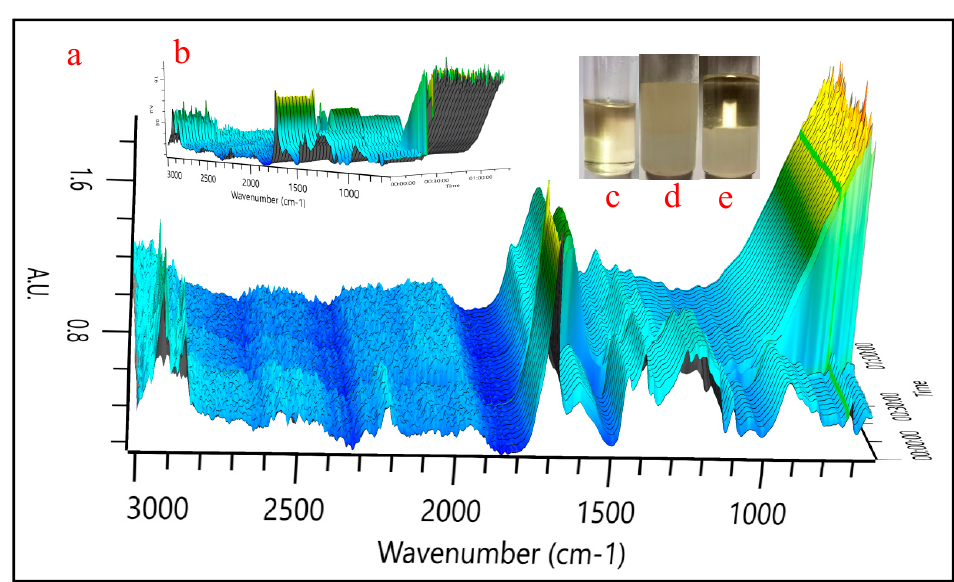
Figure 8. In situ IR spectra of NADESs and simulated phenol wastewater (0.5 and 100 mg L − 1 ). ( a , b ) Front and side views of in situ IR spectra; ( c – e ) diagram of phenol extraction process.